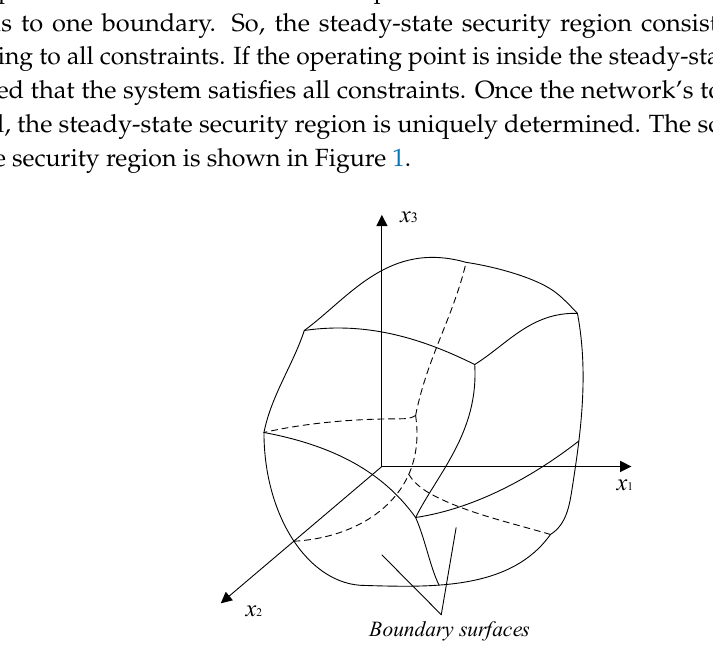
Figure 1. Schematic diagram of the steady-state security region.